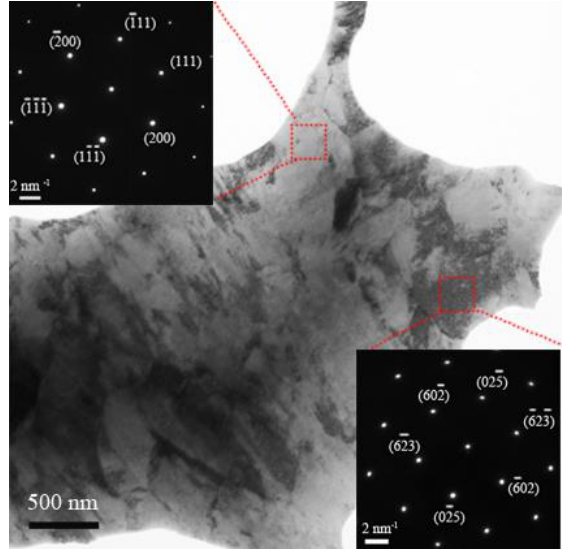
Figure 6. XRD of the PMEDA machined surface with 12A peak current.